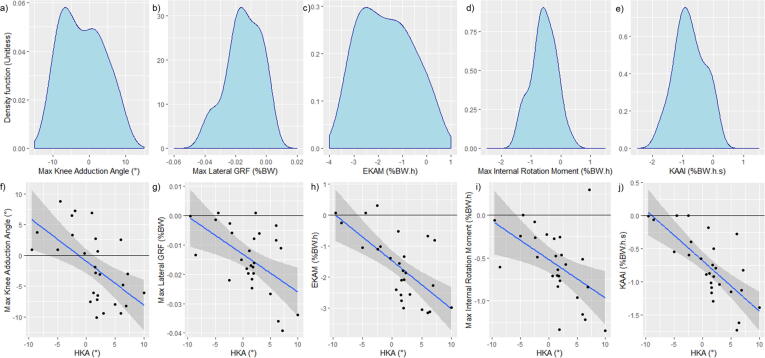
Density (a-e) and scatter plots (f-j) of significant relationships between HKA and Gait analysis outputs.